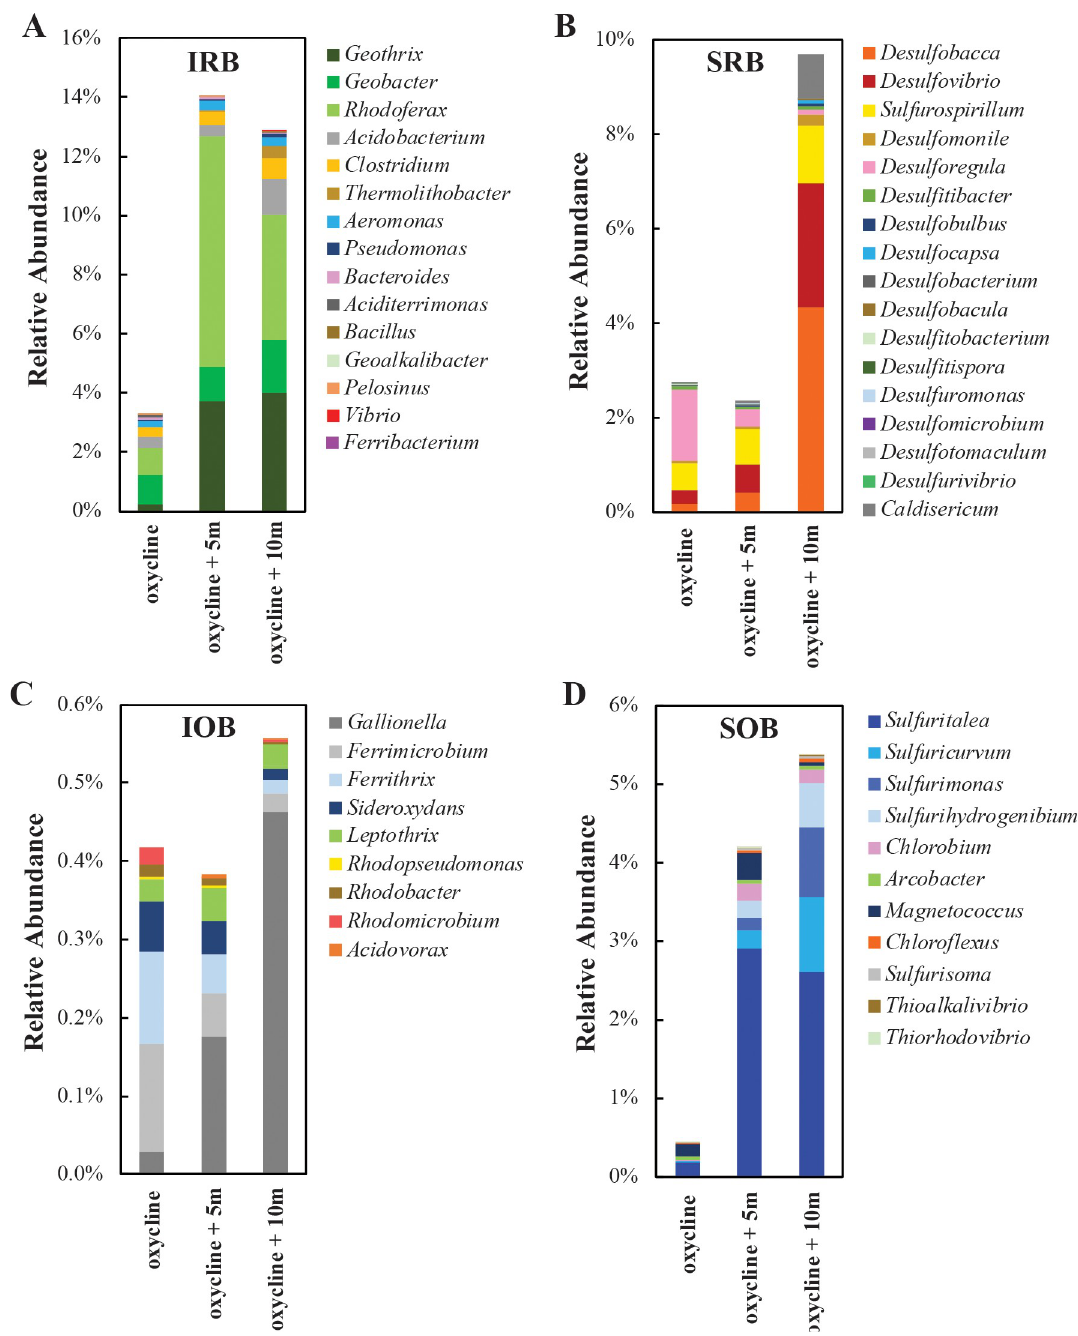
Fig 3. Diversity of iron and sulfur-cycling bacteria in the Lake Pavin monimolimnion. Bacterial 16S rRNA gene amplicon libraries were obtained from 0 m, 5 m, and 10 m below the oxycline. Sequences were classified based on best BLAST hit results, and putative iron and sulfur metabolizing bacteria were identified based on phylogenetic affiliation with (A) iron reducing bacteria = IRB, (B) sulfur/sulfate-reducing bacteria = SRB, (C) iron oxidizing bacteria = IOB, and (D) sulfide oxidizing bacteria = SOB.